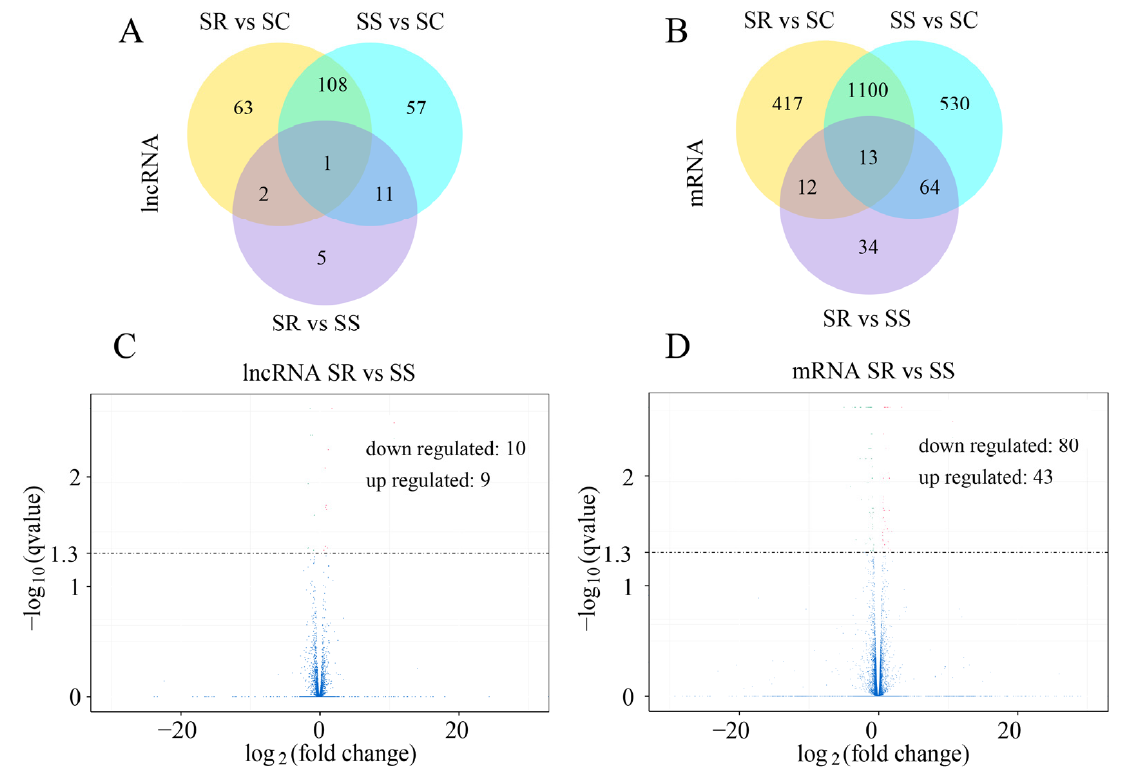
Figure 1. Analysis of DE lncRNAs and mRNAs in the spleen. Venn diagram showing DE lncRNAs Curr. Issues Mol. Biol. 2023 , 3 , FOR PEER REVIEW